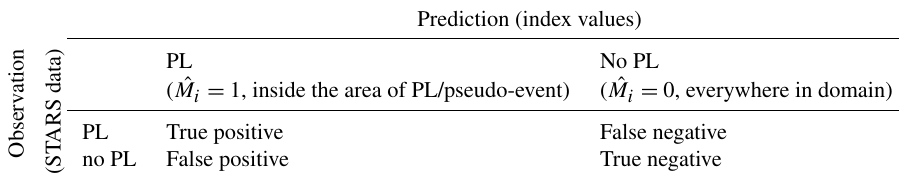
Table E2. Confusion matrix summarizing the classification scheme for task 2. In task 2 we test the performance of indices in distinguishing the time and location of PL